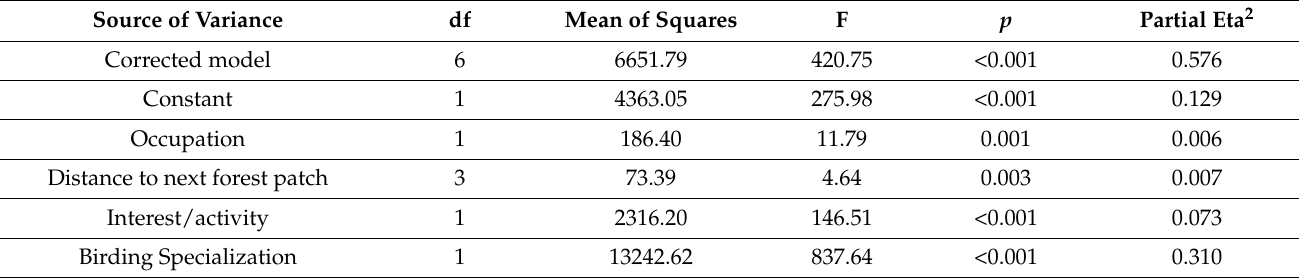
Figure 2. Bird identification scores in relation to distance to next forest patch (mean and 95 CI given derived from the general linear model). Table 4. Results of a General Linear Model with identification score as dependent variable and occupation, distance to next forest patch as fixed factors, and birding specialization and interest as covariates. Levene test: p =